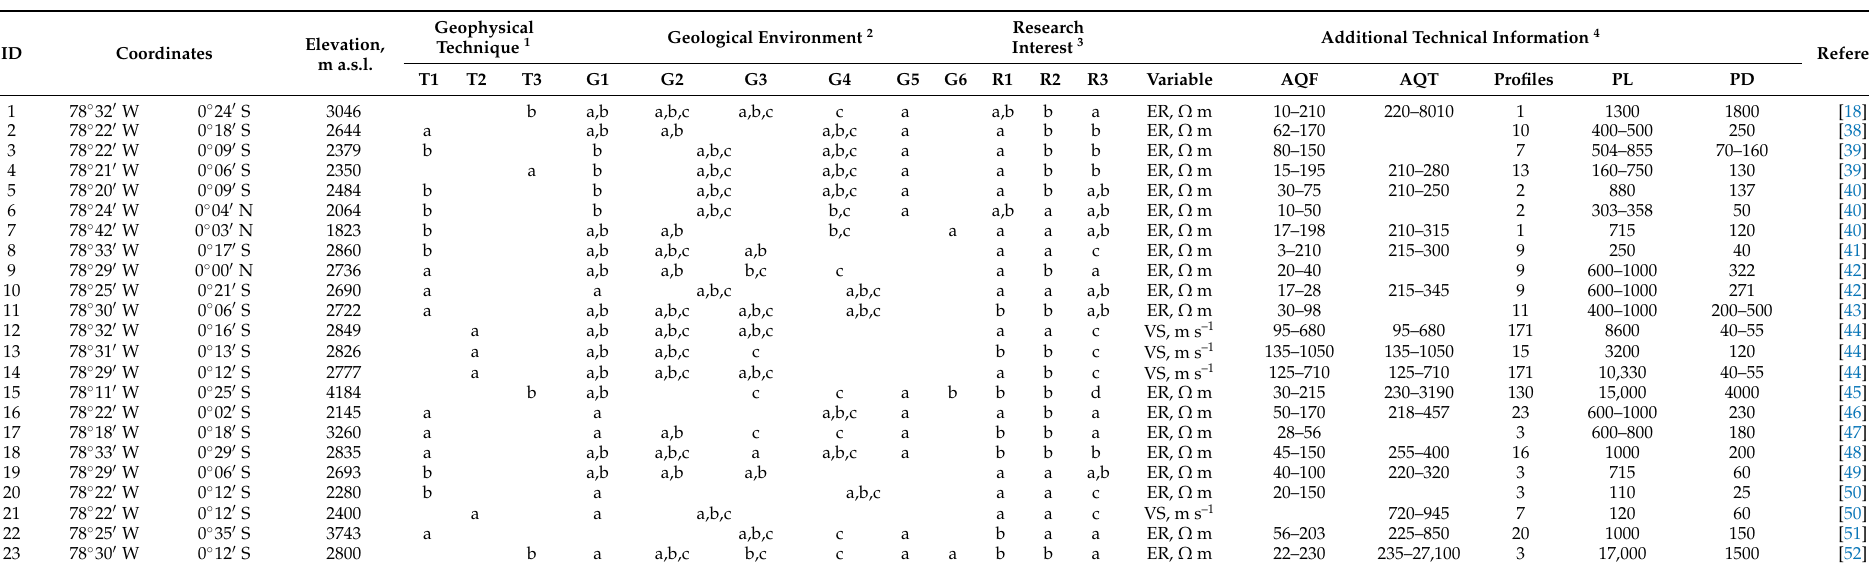
Table 2. Database comprising the compiled 23 geophysical prospecting surveys of interest in groundwater research in the MDQ. The data are clustered according to the applied geophysical prospecting technique, explored aquifer typology, deduced transient groundwater features, and additional technical